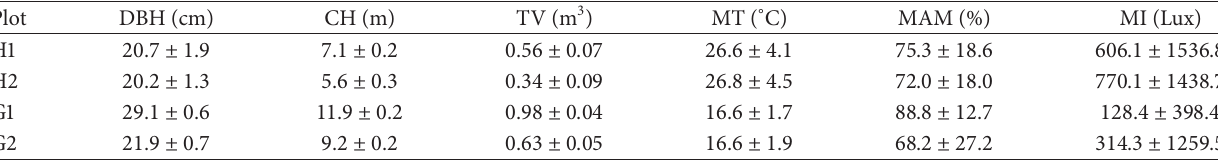
Table 1: Basic parameter values and standard deviations of the forest subtype characterization performed in the present study. Plot DBH (cm) CH (m) TV (m 3 ) MT ( ∘ C) MAM (%) H1 20.7 ± 1.9 H2 20.2 ± 1.3